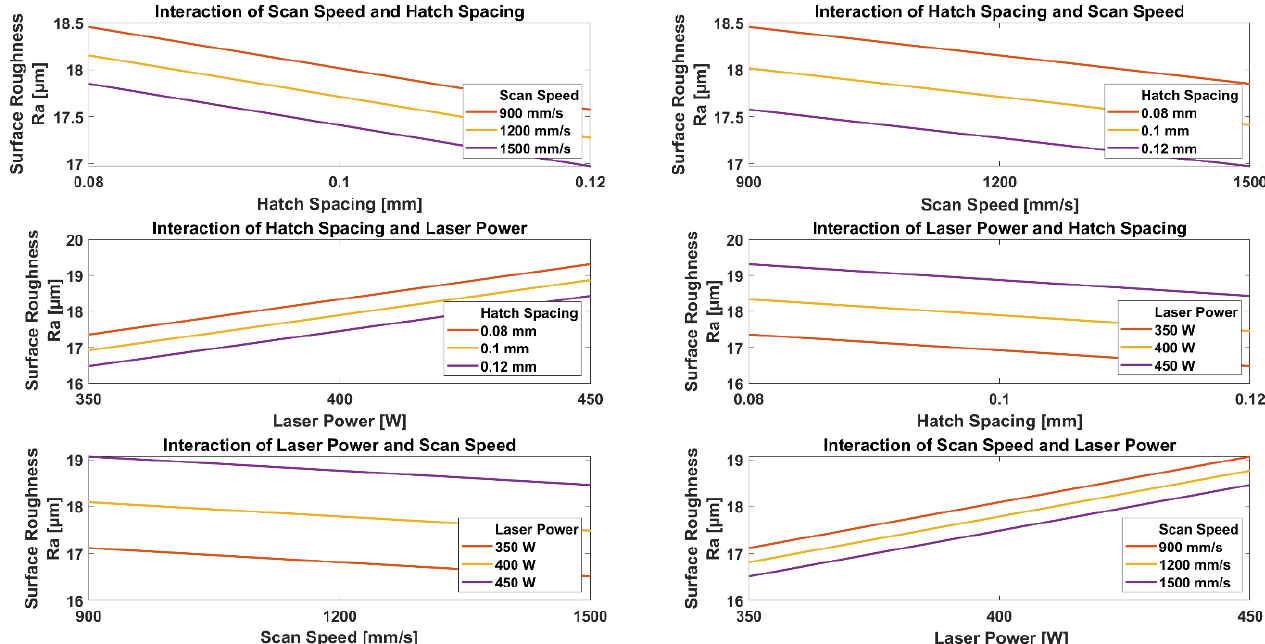
Figure 11. Effects of the interaction of parameters on the measured R a on the side surface.